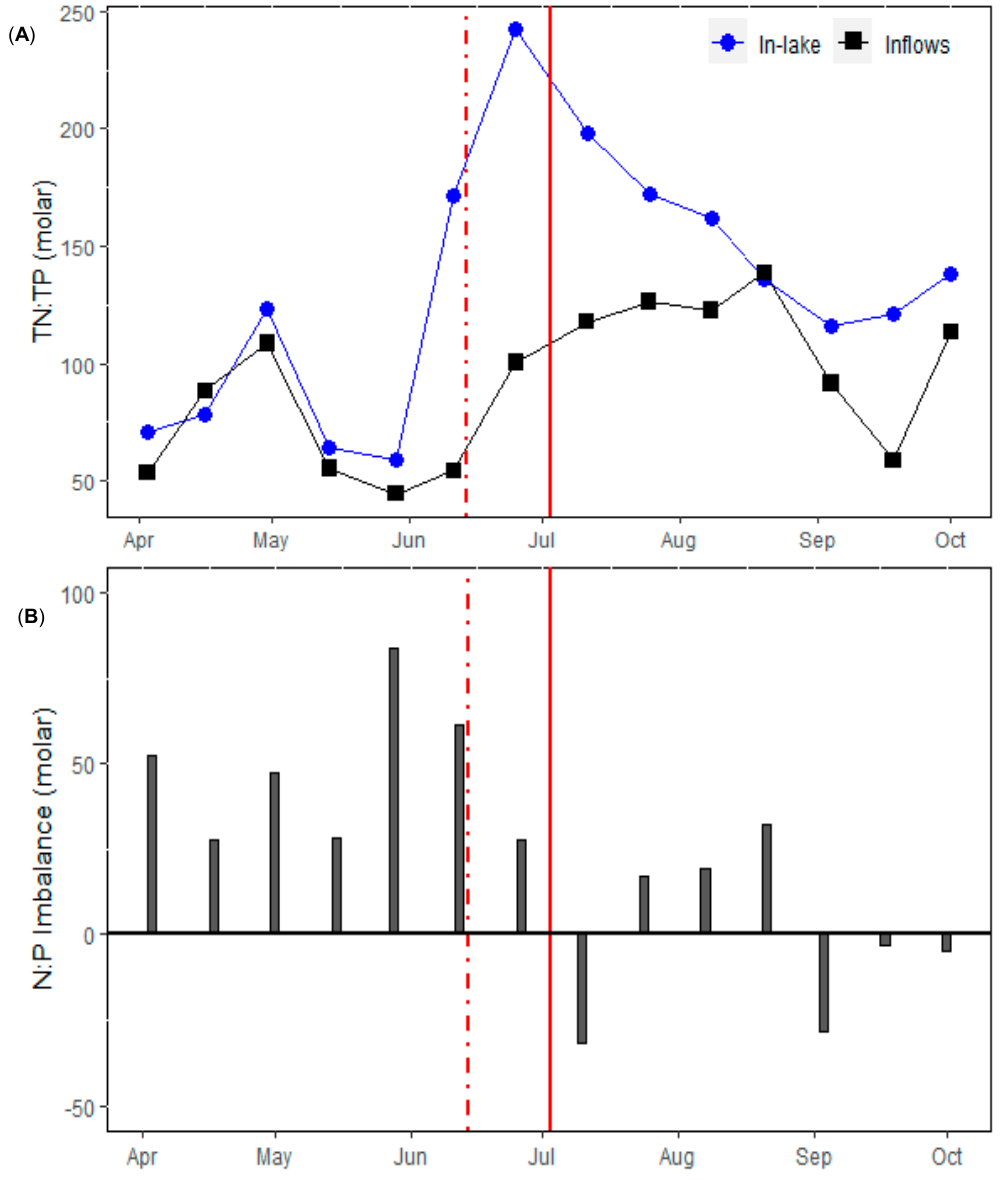
Figure 5. ( A ) TN:TP nutrient ratios of Lough Feeagh (blue circles) and loadings to Lough Feeagh (black squares) and ( B ) Lough Feeagh N:P nutrient imbalances (seston N:P minus zooplankton community N:P) from April to October 2018. Ratios are performed in molar units. Dotted red lines indicate the Storm Hector event and solid red lines indicate when the Feeagh water column returned to more stable stratification conditions.